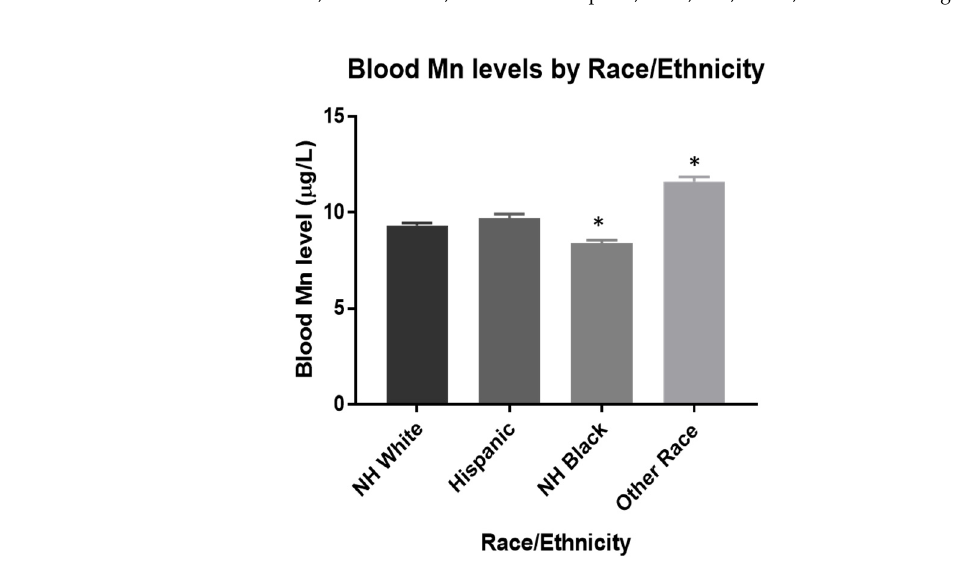
Figure 2. Estimated mean urinary Mn levels were 0.19, 0.13, 0.15, and 0.14 µg/L for NH-White ( n = 451), Hispanic ( n = 176), NH-Black ( n = 225), and Other Race ( n = 98), respectively. Data were ana- lyzed by One-way ANOVA with Tukey’s post-hoc test holding NH White as the control. The limit of detection used was 0.13 µg/L. 4. Discussion To our knowledge, this is the first study to investigate possible associations between blood and urinary Mn levels and cognitive function in an elderly US-based population. We found significant inverse associations between blood and urinary Mn levels with cog- nitive function when stratified by four cognitive function tests, while there was no signif- icant association between blood and urinary Mn levels and composite outcome z-score. Specifically, blood Mn was inversely associated with CERAD (immediate) after adjusting